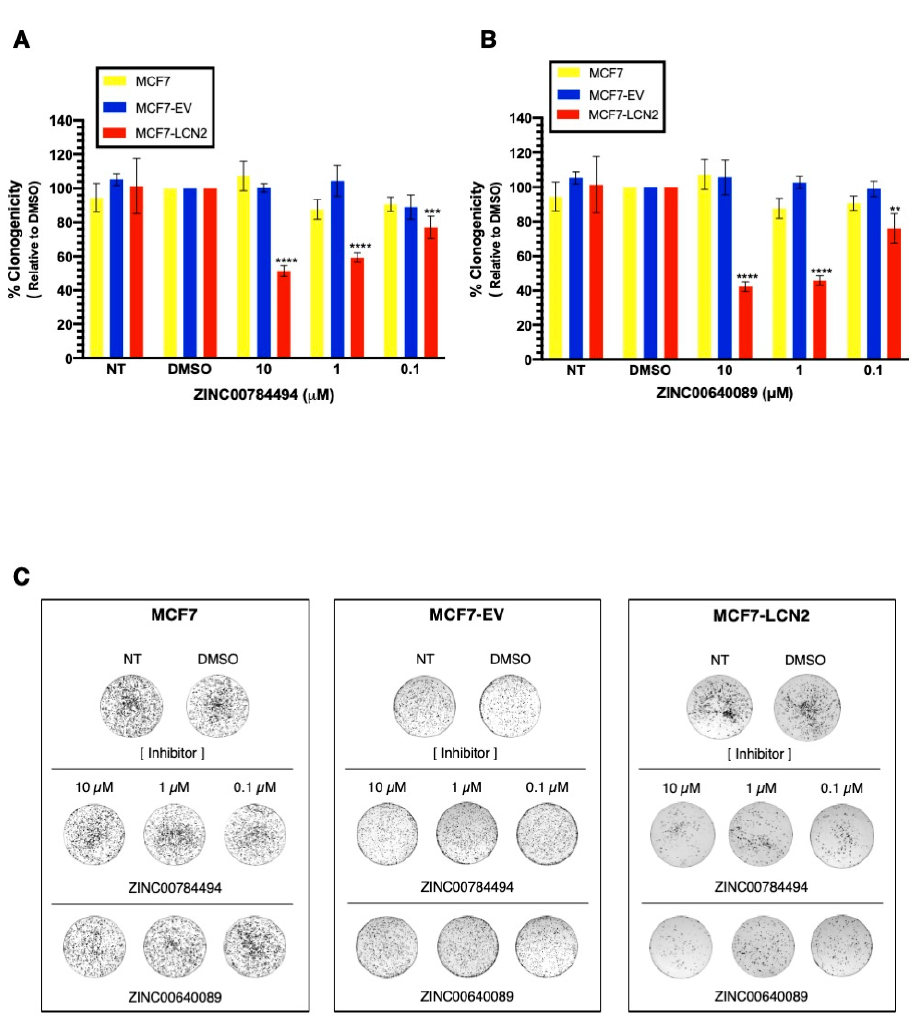
Figure 7. LCN2-inhibitors ZINC00784494 and ZINC00640089 showed specificity toward LCN2-calyx. Cell proliferation in MCF7, MCF7-EV and, MCF7-LCN2 cells after treatment with ( A ) ZINC00784494 inhibitor and ( B ) ZINC00640089 inhibitor. ( C ) A representative clonogenic assay of MCF7, MCF7-EV, and MCF7-LCN2 treated with ZINC00784494 and ZINC00640089. Results are shown as Mean ± SEM of triplicate experiments (** p < 0.01, *** p < 0.001, **** p <